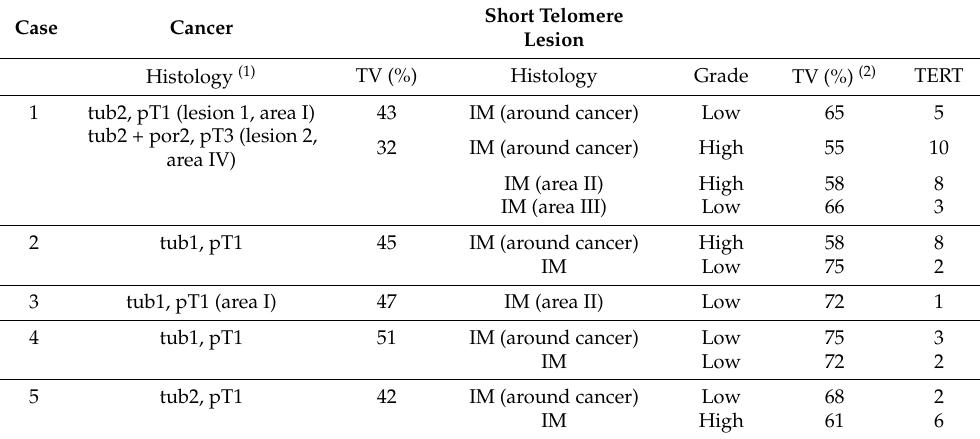
(1) Histology and invasive depth were classified in according to Japanese Classification of Gastric Cancer [20]. Tub1, well-differentiated tubular adenocarcinoma; tub2, moderately differentiated tubular adenocarcinoma; por2, poorly differentiated adenocarcinoma, non-solid type; pT1, Tumor confined to the mucosa or submucosa; pT3, tumor invades the subserosa (SS). (2) TV is noted as a relative value when the TV value of intramucosal infiltrating lymphocytes is 100%. TV, telomere volume; TERT, telomerase reverse transcriptase; IM, intestinal metaplasia.